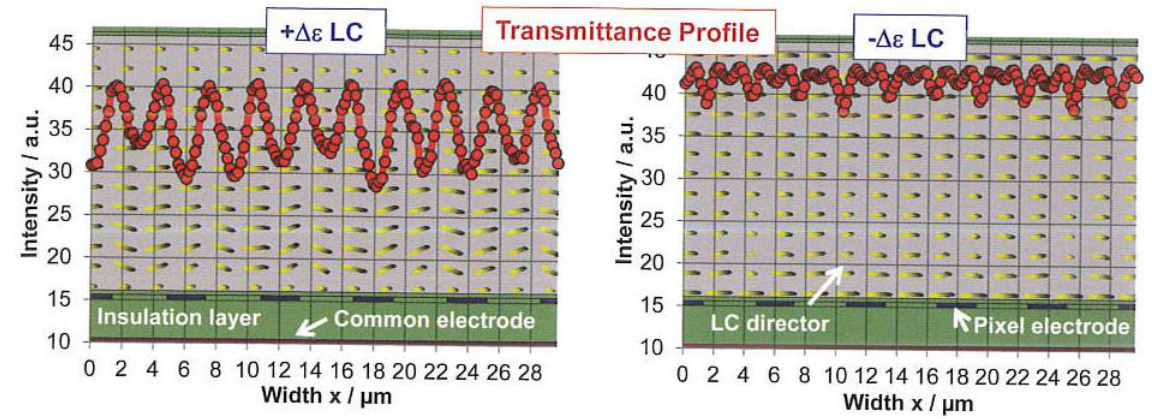
Figure 1. Comparison of rotation angle between positive and negative dielectric anisotropy liquid crystal in FFS mode.